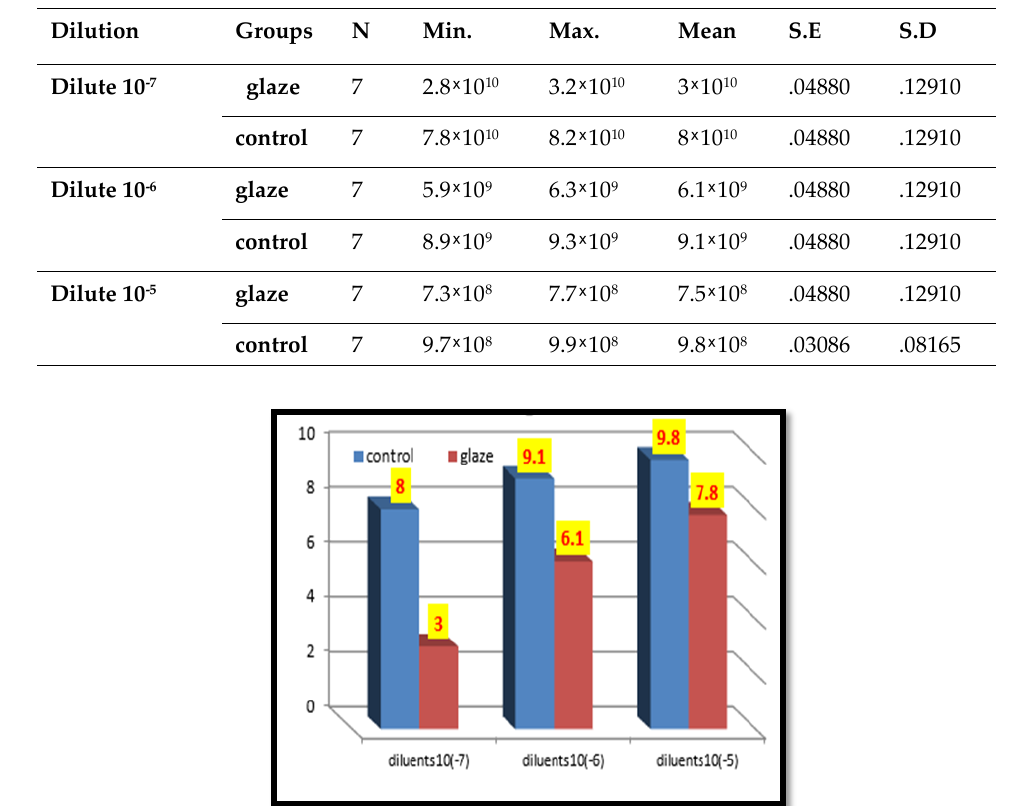
Table 4: Descriptive of viability count